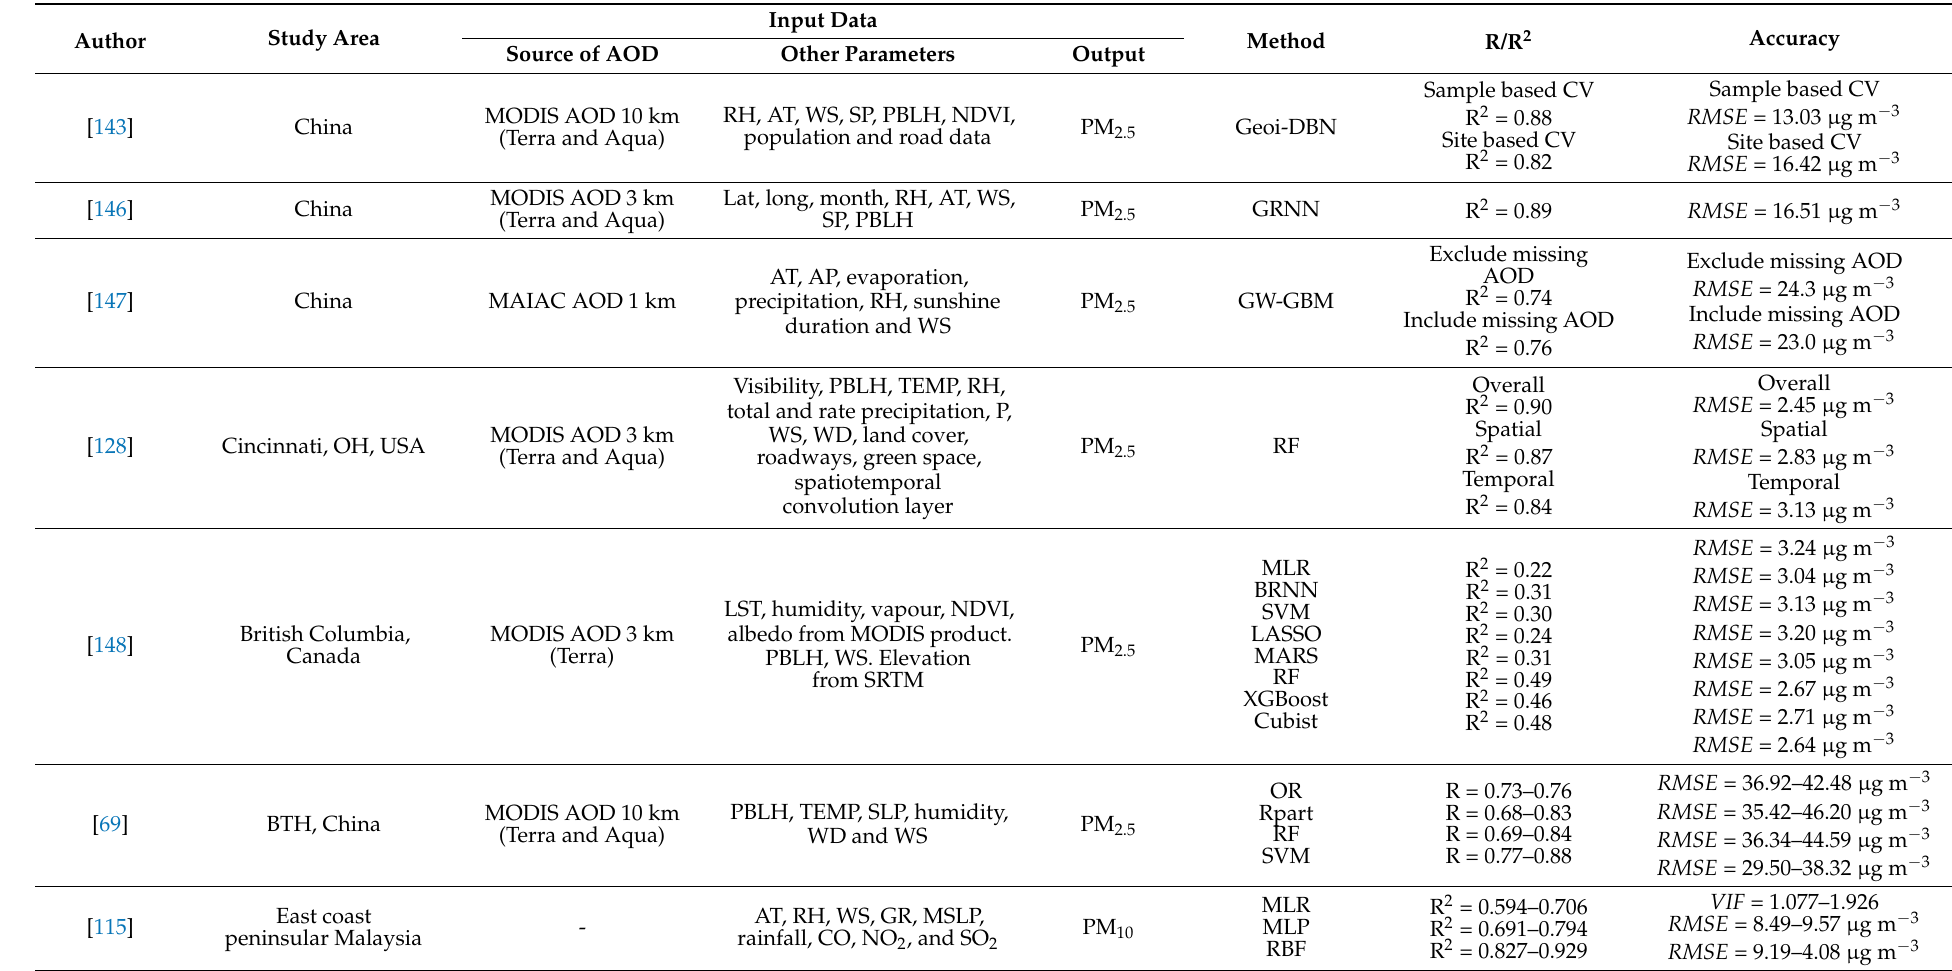
Table 2. Results from previous studies using machine learning techniques for PM estimations from